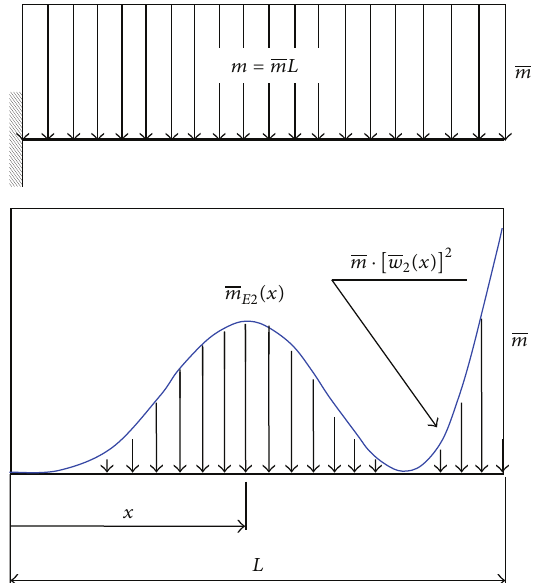
Figure 4: The uniformly distributed inertial mass, loading on the cantilever beam in mode two, and the mass participation in the kinetic energy of each